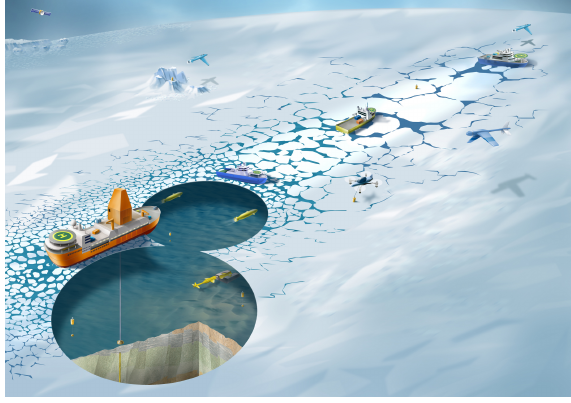
Figure 1: Illustration of a possible future Arctic dy- namic positioning operation that consists of many important components, including icebreakers, unmanned underwater vehicles, and unmanned aerial vehicles. Picture cour- tesy of Bjarne